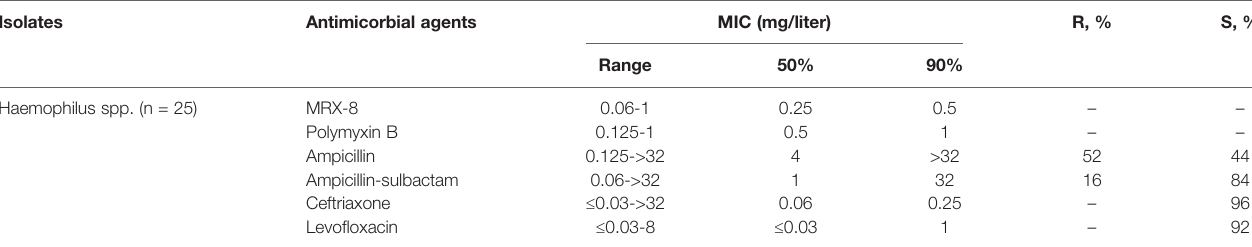
TABLE 7 | In vitro activity of MRX-8 and other comparator agents against 25 of Haemophilus spp. (mg/L).